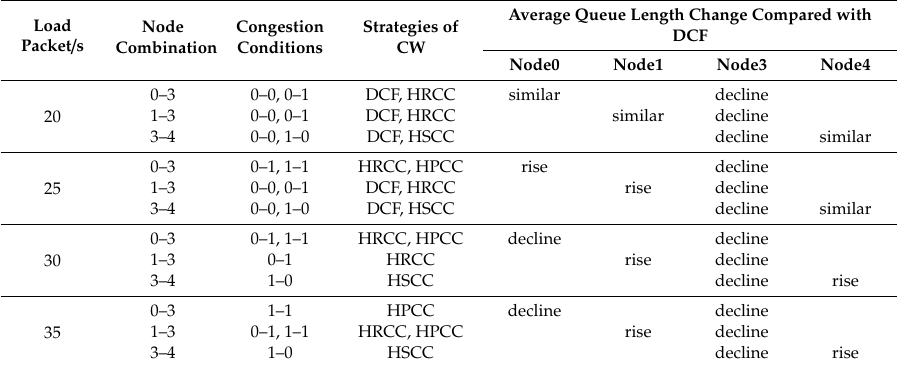
Table 4. Adjustment e ff ect of the HBCC